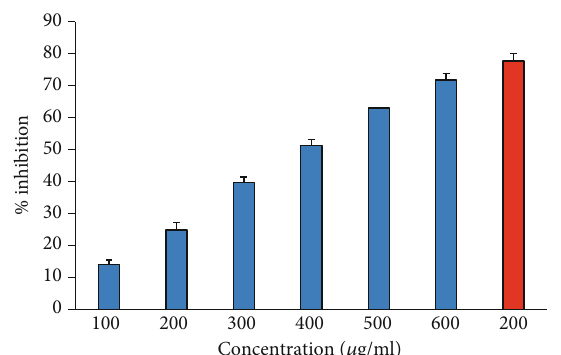
Figure 3: Percentage protection of heat-induced denaturation of egg albumin. Blue columns (1-6) at x -axis represent concentration 100-600 μ g/ml of gingerol, and red column shows concentration 200 μ g/ml of diclofenac. The results are presented as means ± SEM ( n = 3 , p < 0 : 05 ).